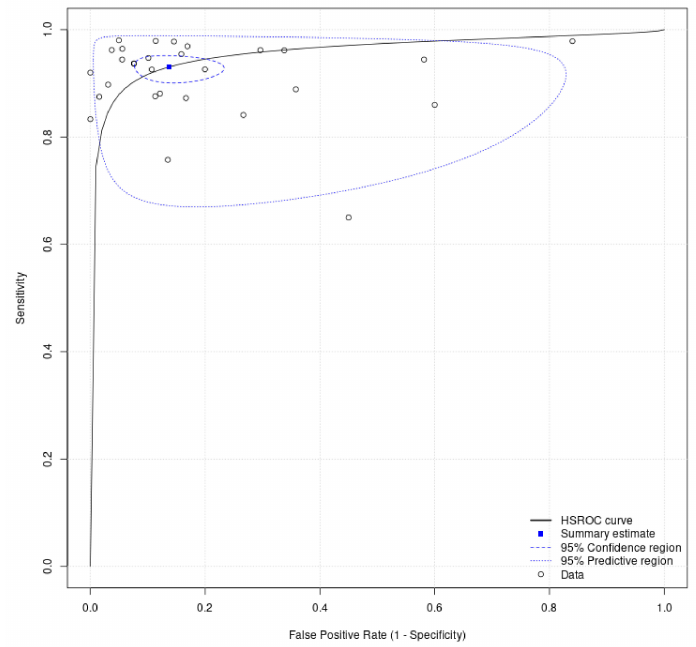
Figure 3. The summary of the area under the receiver operating curve for diagnosis of esophageal